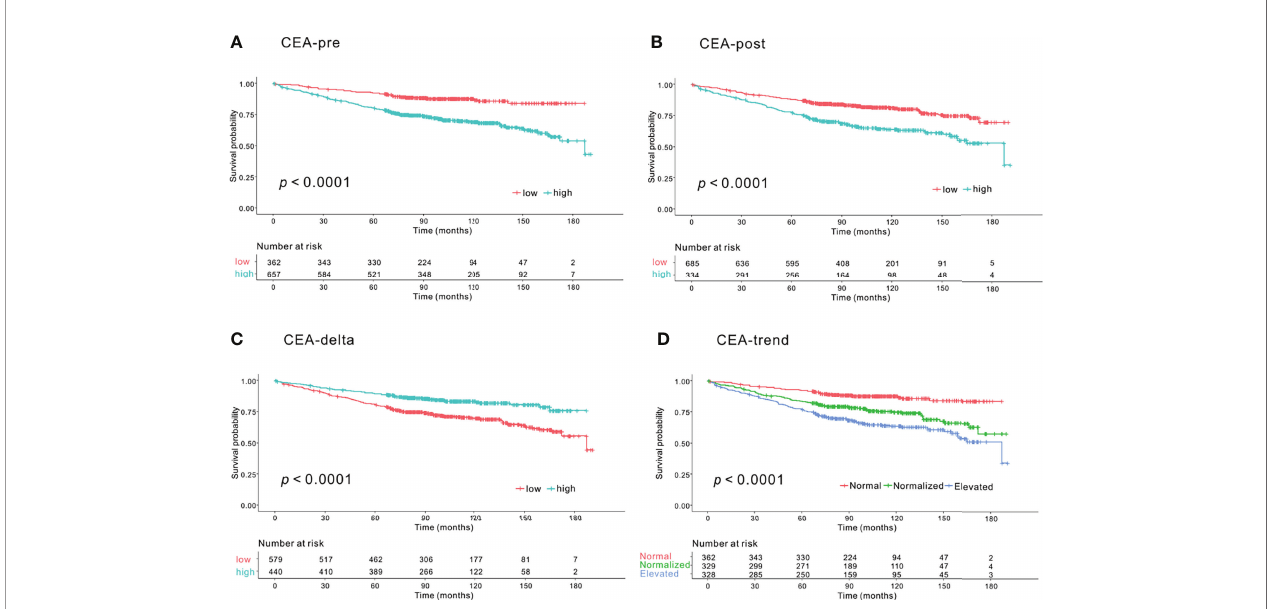
FIGURE 1 | Kaplan – Meier survival curve analysis of groups according to carcinoembryonic antigen (CEA) level for overall survival (OS). (A) Preoperative CEA (CEA- pre). The low CEA-pre group (CEA-pre <2.3 ng/mL) showed better OS than the high CEA-pre group (CEA-pre <2.3 ng/mL) (5-year OS: 92.2% vs. 80.4%, p <.0001). (B) Early postoperative CEA (CEA-post). The low CEA-post group (CEA-post <2.3 ng/mL) showed better OS than the high CEA-post group (CEA-post <2.3 ng/mL) (5-year OS: 87.9% vs. 77.9%, p <.0001). (C) CEA level change (CEA-delta). The low CEA-delta group (CEA-delta <-0.93 ng/mL) had worse OS than the high CEA- delta group (CEA-delta <-0.93 ng/mL) (5-year OS: 80.8% vs. 89.5%, p <.0001). (D) CEA-trend. The normal CEA group (low CEA-pre group) had the best OS followed by the normalized (high CEA-pre and low CEA-post group) and elevated CEA groups (high CEA-pre and high CEA-post groups) (5-year OS: 92.2% vs. 83.5% vs. 77.2%, p